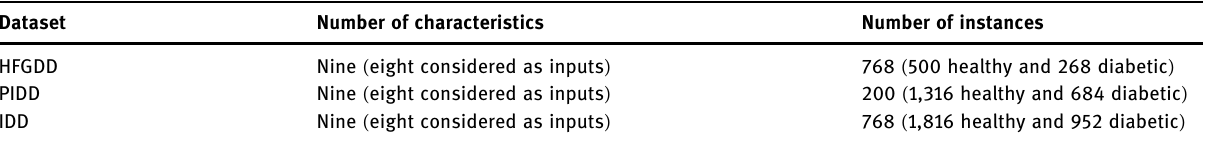
Table 1: Dataset description Dataset